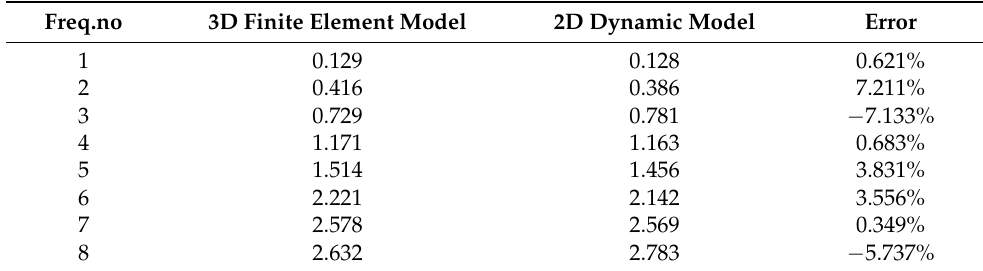
Table 1. Comparison of dynamic properties of the 3D and 2D models.